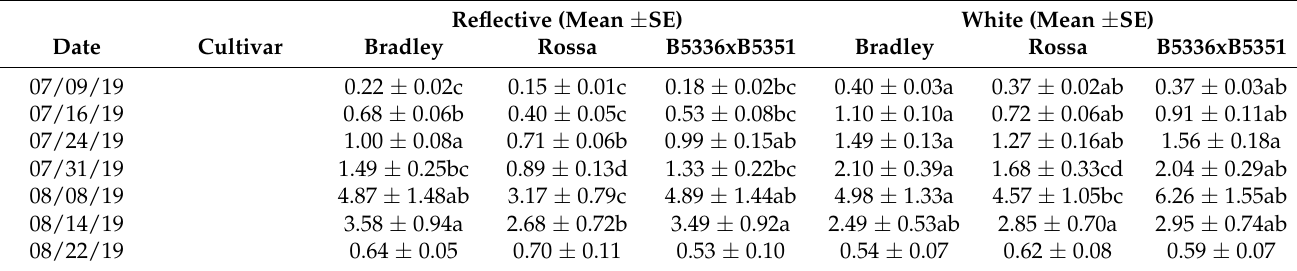
Table 3. Significant effects of highest order interactions on mean ( ± SE) adult thrips densities per leaf. Significant effects include the interactions of date × mulch type × biopesticide in 2019. Thrips were counted weekly for seven weeks. Means with different letters within a row are significantly different at α = 0.05 using Tukey’s LSD post hoc test. Reflective (Mean ± SE) White (Mean ±